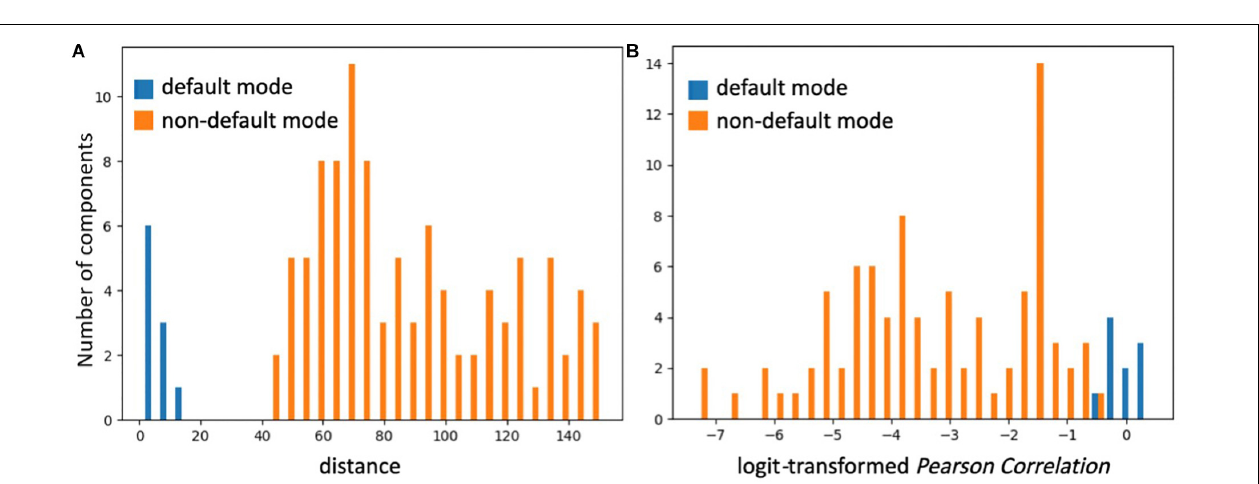
FIGURE 9 | Four examples from the CNRM and Milwaukee-b datasets showing the ICA component that best represents the desired RSN labeled by SiameseICA (top row) but not correctly identified by Pearson correlation with five references per class (bottom row). Values above each image represent the metric derived by SiameseICA (left, denoted D) and Pearson correlation (right, denoted